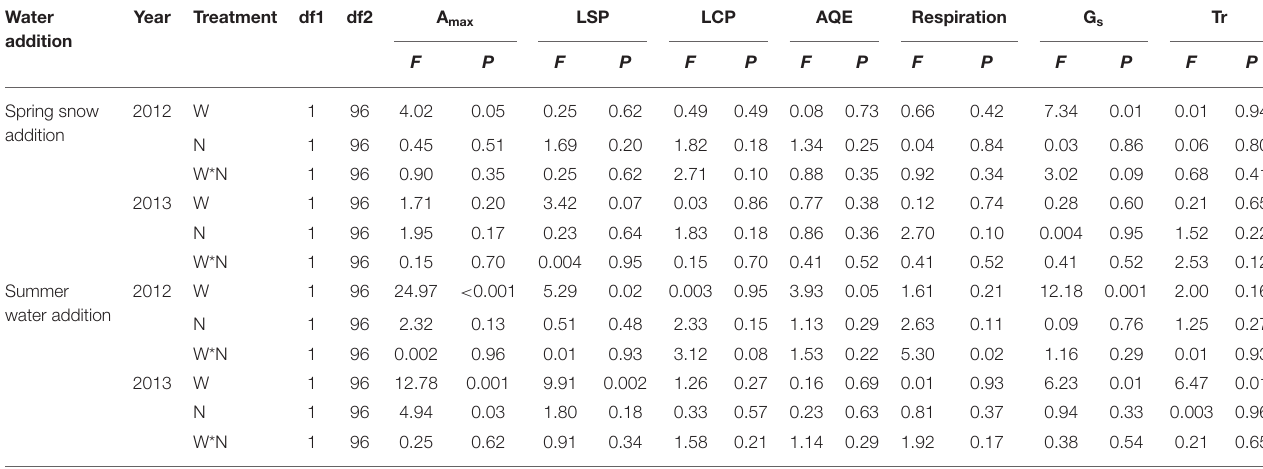
TABLE 1 | Results ( F- and P -values) of mixed-model analysis on the effects of water (W; including spring snow and summer water), N application (N), and their interactions on the maximum photosynthetic rate (A max ), light saturation point (LSP), light compensation point (LCP), maximum apparent quantum yield (AQE), respiration, stomatal conductance (G s ), and transpiration rate (Tr) of Leymus chinensis in 2012 and 2013. Water addition